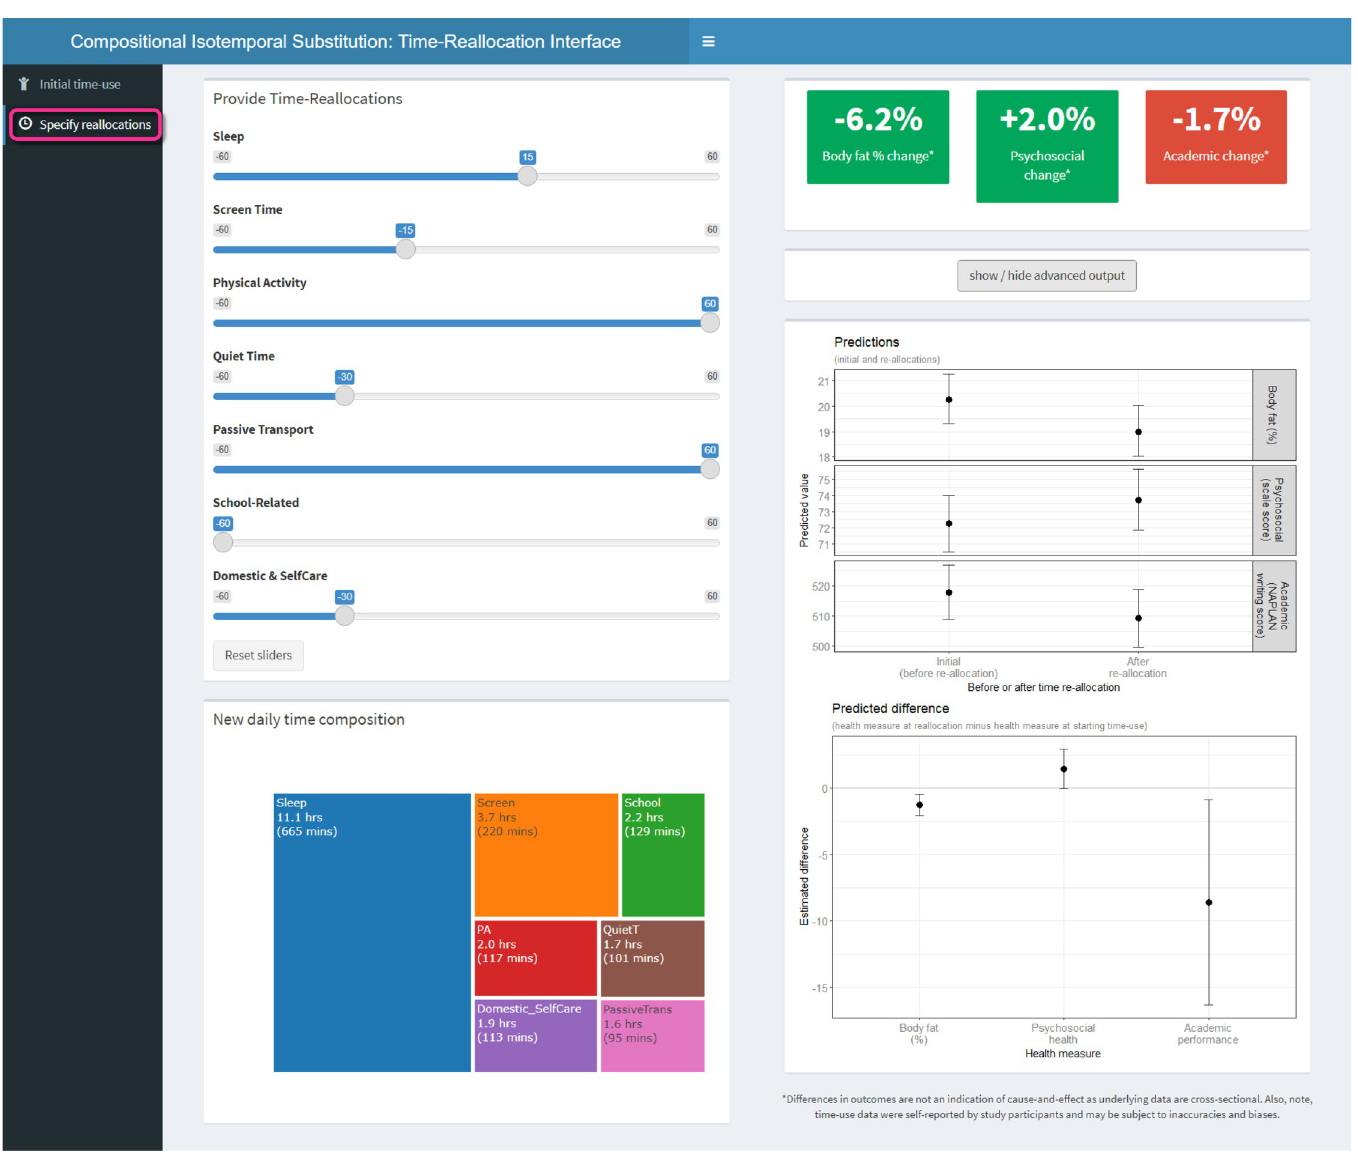
Fig 5. Specification of the same complex reallocation as in Fig 4, but relative to a different initial composition where Sleep = 10 h 50 min; Screen time = 3 h 55 min; Physical activity = 57 min; Quiet time = 2 h 11 min; Passive transport = 35 min; School-related activities = 3 h 09 min; Domestic/self-care activities = 2 h 23